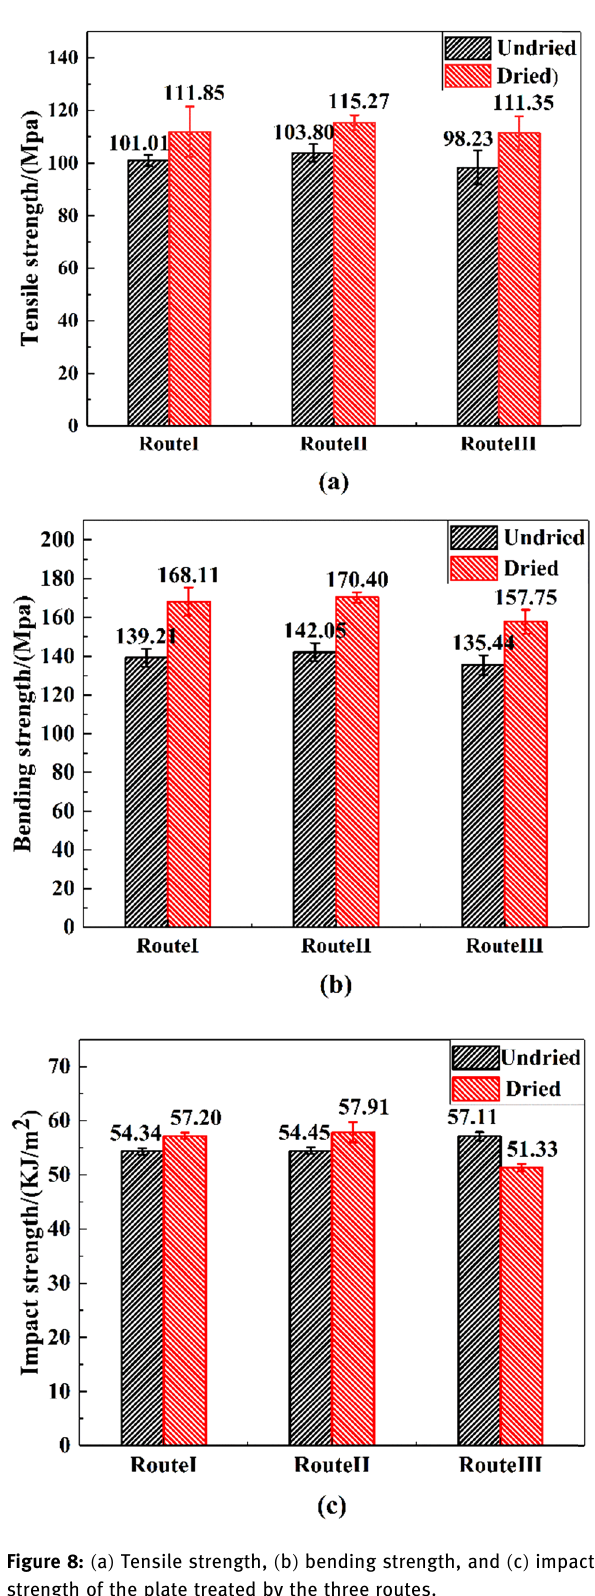
Figure 8: ( a ) Tensile strength, ( b ) bending strength, and ( c ) impact strength of the plate treated by the three